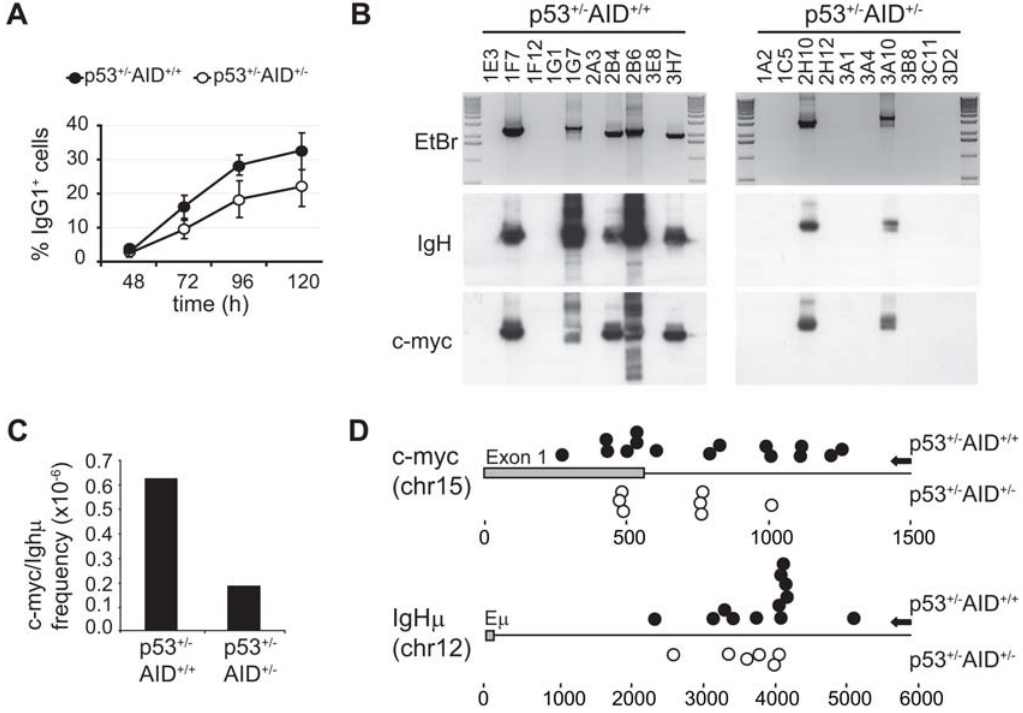
Figure 4. c-myc/IgH translocation frequency is reduced in activated AID + / 2 B cells. (A) p53 + / 2 AID + / 2 cells are haploinsufficient for CSR. Spleen B cells from p53 + / 2 AID + / + and p53 + / 2 AID + / 2 were stimulated for the indicated times (X axis) in the presence of LPS and IL4. Percentage of IgG1 + as measured by flow cytometry is represented (Y axis). Statistical bars show standard deviations. p values (p53 + / 2 AID + / 2 vs p53 + / 2 AID + / + ) 48h, 0.7; 72h, 0.01; 96h, 6 6 10 2 3 ; 120h, 0.03. (unpaired two-tailed t test, n=4). (B) Representative c-myc/IgH translocations detected in p53 + / 2 AID + / + and p53 + / 2 AID + / 2 B cells. Spleen B cells from p53 + / 2 AID + / + and p53 + / 2 AID + / 2 mice were stimulated in vitro in the presence of LPS and IL4 for 3 days. DNA was extracted and proximal translocations were amplified by PCR as depicted in Fig 2a (see materials and methods) and analysed in ethidium bromide stained agarose gels (upper). Specificity of amplification products was determined by southern blot and hybridization with IgH (middle) and myc (lower) probes. Results for p53 + / 2 AID + / + and p53 + / 2 AID + / 2 cells are shown on the left and right gels, respectively. Translocation identifications are indicated above lanes. (C) Frequency of c-myc/IgH translocations in p53 + / 2 AID + / + and p53 + / 2 AID + / 2 B cells. Translocation frequency was determined by serial dilution of DNA samples, followed by PCR amplification, cloning and sequencing. (D) Representation of translocation breakpoints at the c-myc and IgH m genes found in p53 + / 2 AID + / + and p53 + / 2 AID + / 2 B cells. Amplification products of c-myc/IgH translocations were cloned and sequenced. Translocation breakpoints at the c-myc (upper diagram) and IgH (lower diagram) genes are shown as closed (p53 + / 2 AID + / + ) and open (p53 + / 2 AID + / 2 ) circles. C-myc exon 1 and IgH E m enhancer are represented as grey boxes and distance to these elements is shown underneath (bps). Arrows on the right indicate the position of the PCR oligonucleotides used for amplification.